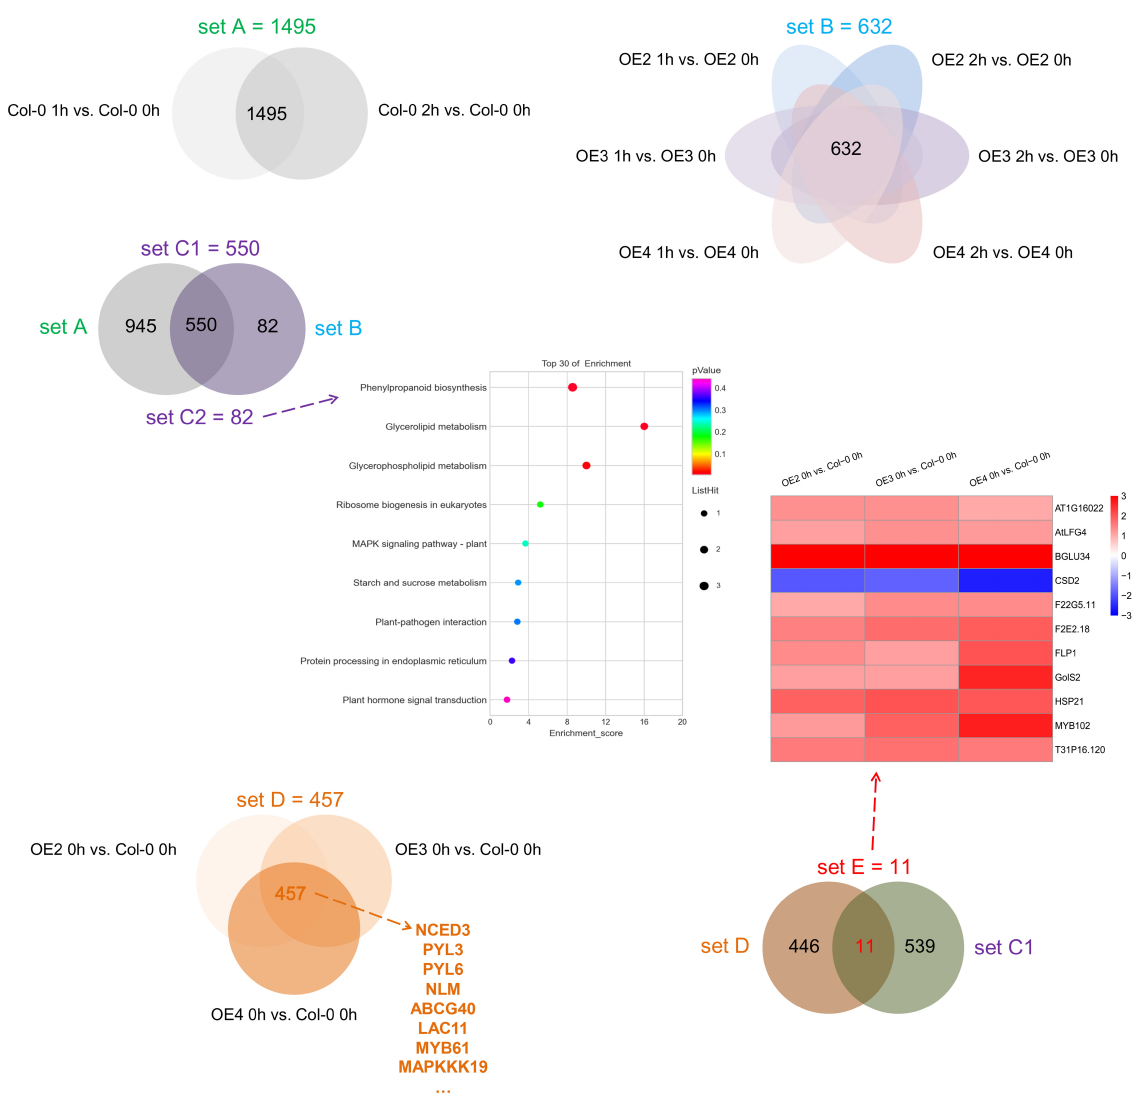
Figure 6. Differentially expressed genes (DEGs) identified by comparing between normal and high- temperature-exposed control (Col-0) and VvDREB2c-transgenic Arabidopsis. Set A: DEGs from normal and high-temperature-treated Col-0 (Col-0 1 h vs. Col-0 0 h and Col-0 2 h vs. Col-0 0 h); Set B: DEGs from normal and high-temperature-treated transgenic lines (OE2 1 h vs. OE2 0 h, OE2 2 h vs. OE2 0 h, OE3 1 h vs. OE3 0 h, OE3 2 h vs. OE3 0 h, OE4 1 h vs. OE4 0 h, and OE4 2 h vs. OE4 0 h); Set C1: DEGs common to sets A and B; Set C2: DEGs from set B, excluding those in set A; Set D: DEGs because of the overexpression of VvDREB2c (OE2 0 h vs. Col-0 0 h, OE3 0 h vs. Col-0 0 h, and OE4 0 h vs. Col-0 0 h). Set E: obtained using sets C and D; DEGs not only because of the overexpres- sion of VvDREB2c, but also induced by high temperature in the four lines.